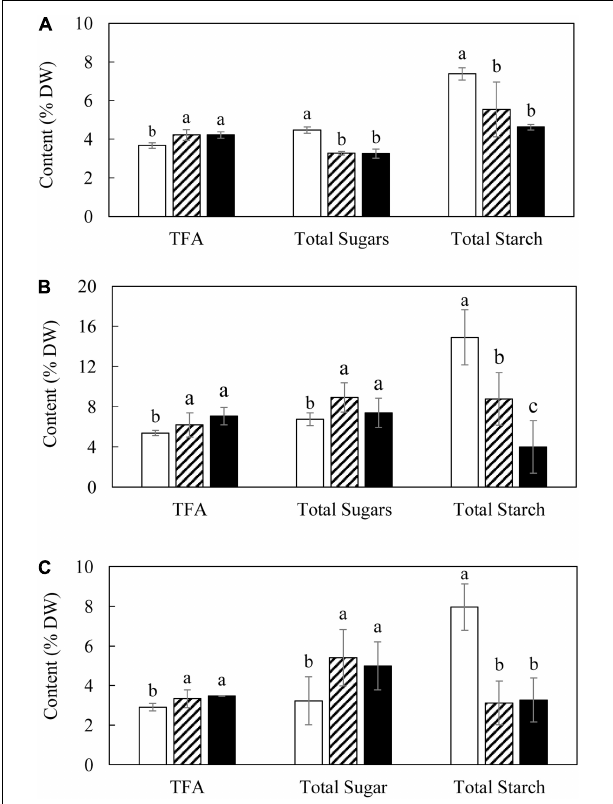
FIGURE 2 | Contents of TFA and total carbohydrate in potato leaves at the three developmental stages in WT (open bar), L3 (bar with upward diagonal) and L5 (black bar). (A) Flowering stage; (B) Mature stage; (C) Senescent stage. The data represent the mean values ± SD of three biological replicates. Letters (a, b, c, and d) above the bars are based on LSD, bars marked with different letters are statistically significantly different at P < 0.05.